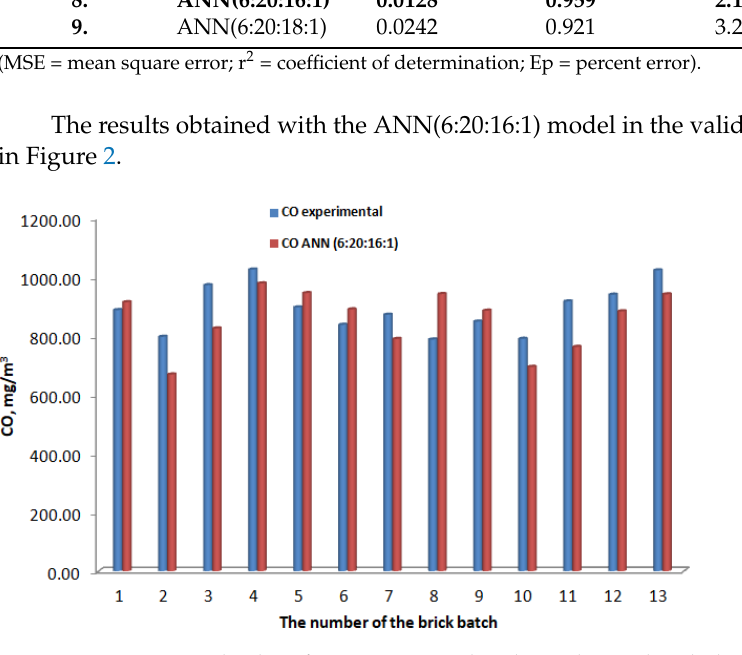
Figure 2. Experimental values for CO compared to those obtained with the ANN(6:20:16:1) model. The mean square deviation calculated by comparing the experimental data with those provided by the ANN (6:20:16:1) model was ± 89.7 mg/m 3 . Neural models constructed to predict the amount of CH 4 resulting in the gas discharge chimney and their performance in the training stage are presented in Table 2. The results obtained indicate that the best performance for CH 4 is obtained with the ANN (6:30:18:1) model. The value of the mean square error calculated for CH 4 is ± 43.8 mg/m 3 and is slightly higher than that obtained for CO. Table 2. Topology and performance of different ANNs constructed and trained for CH 4